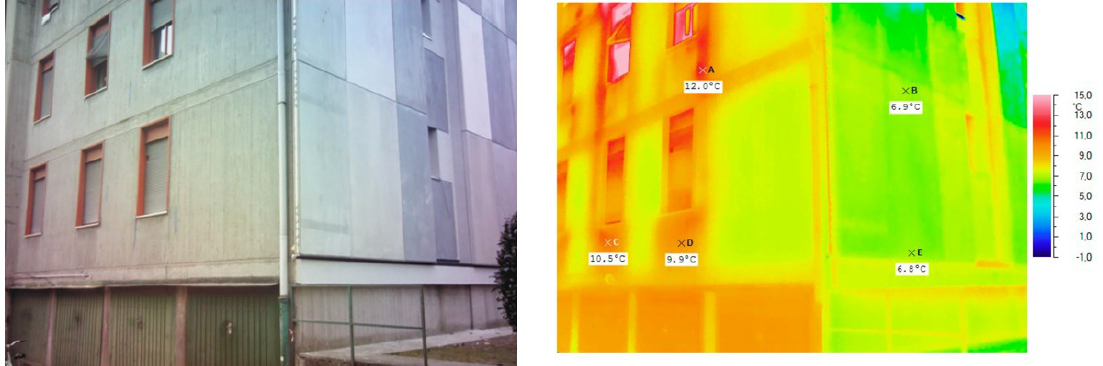
Figure 20. Visible and infrared picture of a portion of the north-east elevation. The red colours identify high thermal energy dispersion due to high wall resistance.